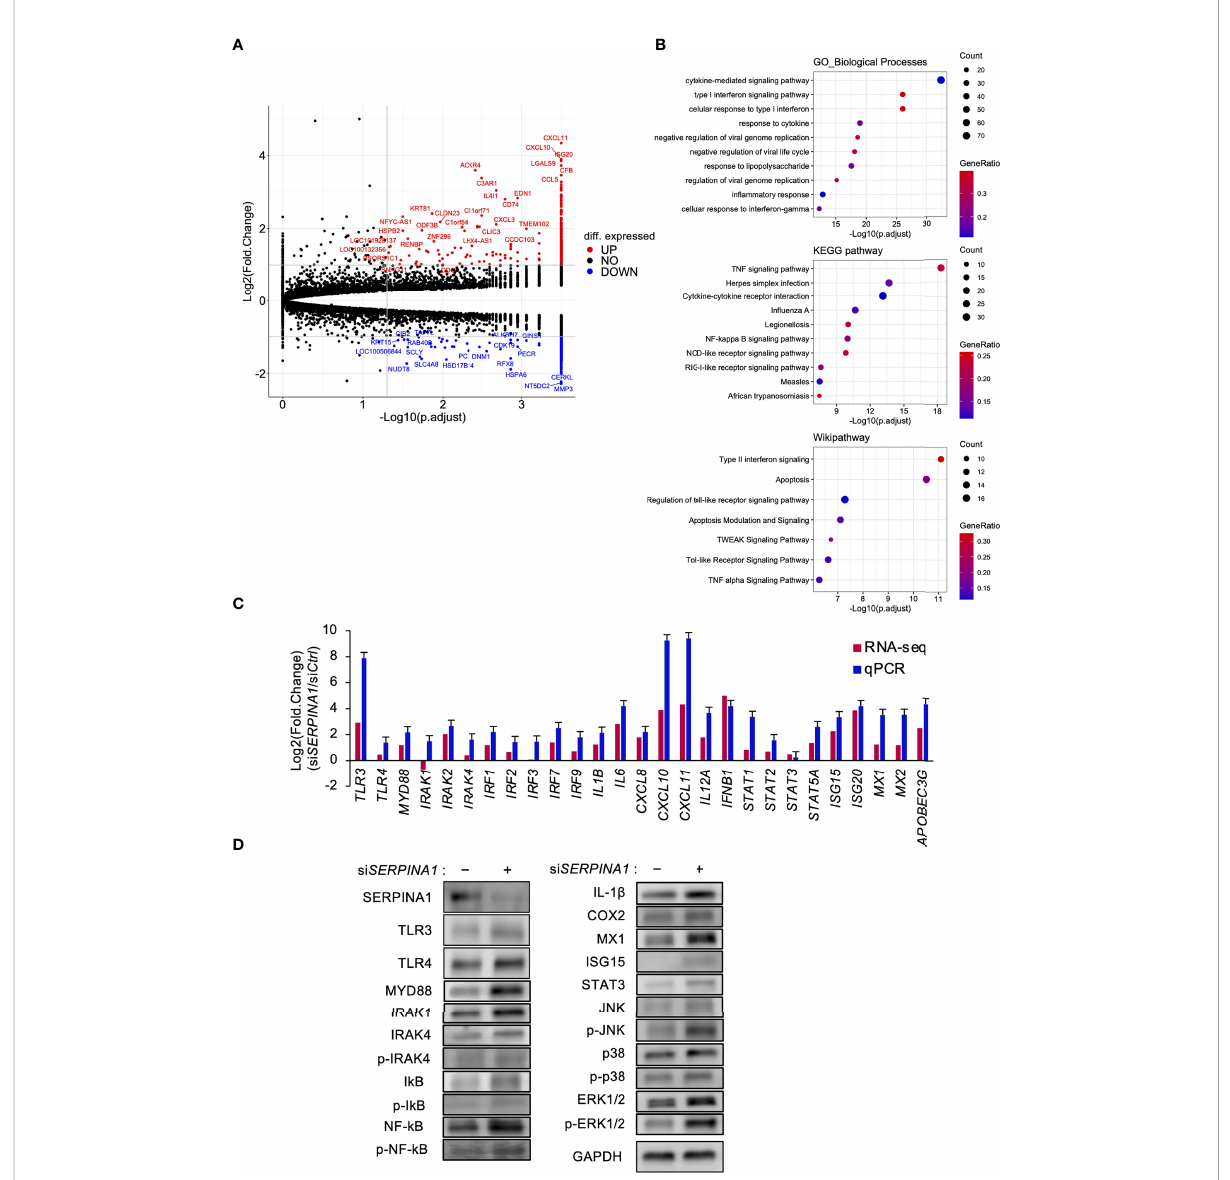
FIGURE 1 Knockdown of SERPINA1 upregulates expression of TLRs in ESCs. ESC lines were transfected for 24 h with siRNA speci fi c for SERPINA1 . Next, RNA was extracted and subjected to RNA sequencing (RNA-Seq; A, B ). (A) Volcano plot showing expression of transcripts identi fi ed by RNA-seq. The transcripts highlighted in red or blue were differentially expressed by 2-fold ( P < 0.05). (B) Differentially expressed genes were functionally classi fi ed using Gene Ontology analysis with the biological process, KEGG pathway, or Wikipathway datasets. (C) Expression of Toll-like receptor-related ( TLR3/4, IRAKs , and IRFs ), in fl ammatory-related ( ILs and CXCLs ), or interferon-related ( IFNB1, STATs, ISGs, MXs , and APOBEC3G ) genes in primary ESCs was measured by qPCR (n=3). GAPDH mRNA was used as the reference gene. Values represent the mean ± SEM of three independent experiments. (D) Lysates prepared from primary ESCs transfected for 24 h with si SERPINA1 were subjected to immunoblotting. GAPDH served as a loading